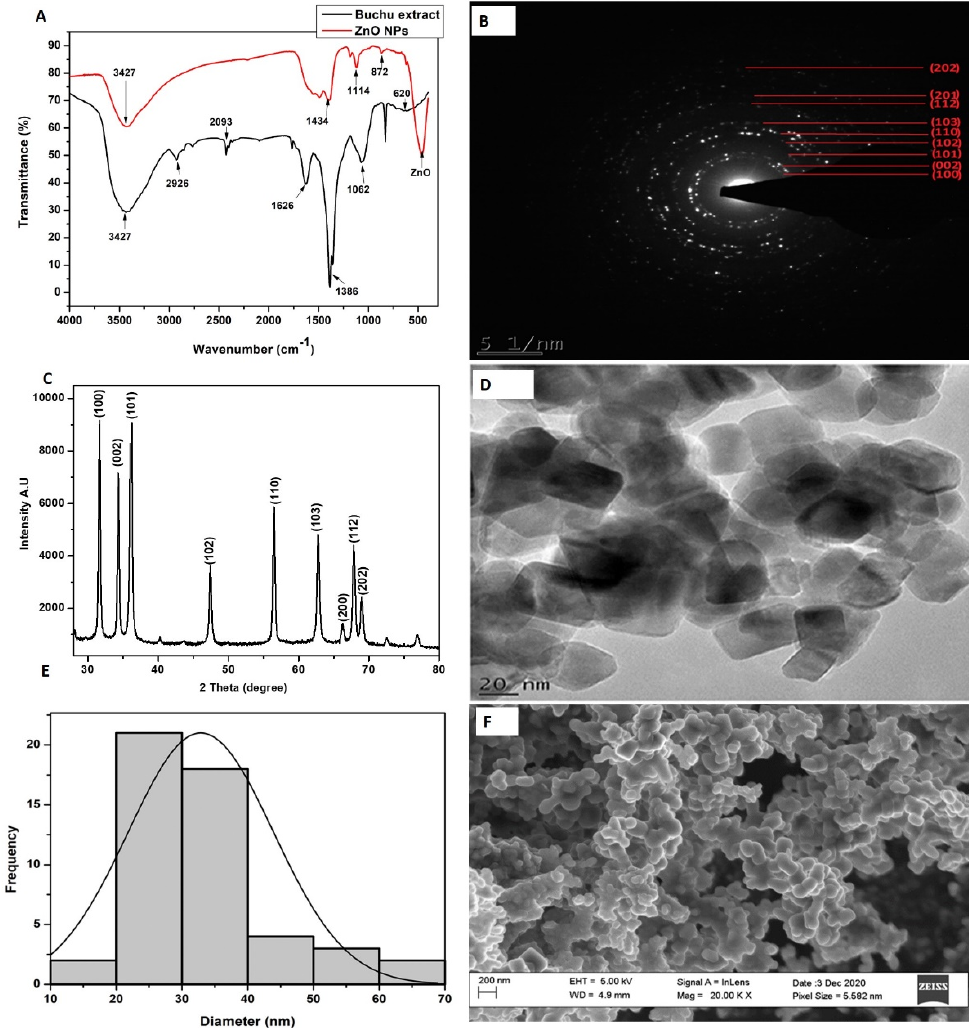
Figure 1. Optical and structural characterization of green-synthesized ZnO NPs using ( a ) FTIR, ( b ) SAED, ( c ) XRD, ( d ) HRTEM, ( e ) HRTEM micrograph, and ( f ) HRSEM analysis. ( B ) SAED, ( C ) XRD, ( D ) HRTEM, ( E ) HRTEM micrograph, and ( F ) HRSEM